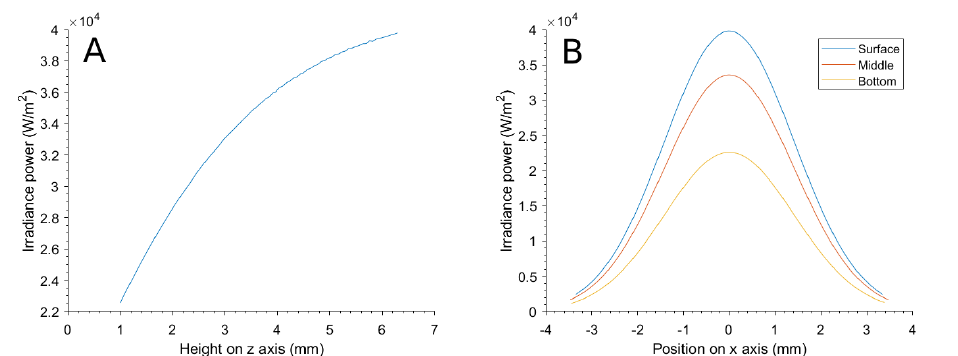
Figure 9. ( A ) Distribution of the laser power over a z-axis line through the center of the suspension and ( B ) over an x-axis line at different z depths.